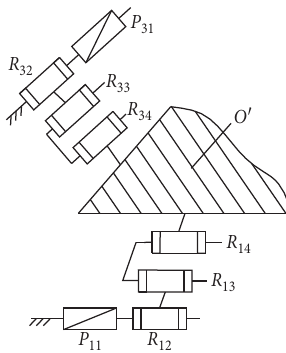
Figure 7: Simplified parallel mechanism.